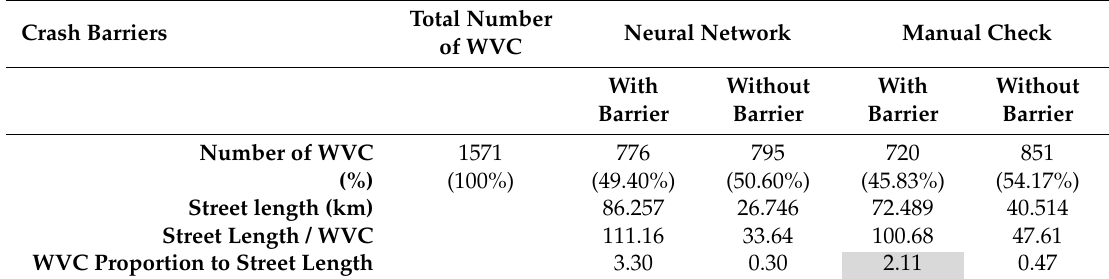
Table 2. Results of WVC numbers at roads with and without crash barriers for the road segments identified by ANN in comparison to the manual classification.